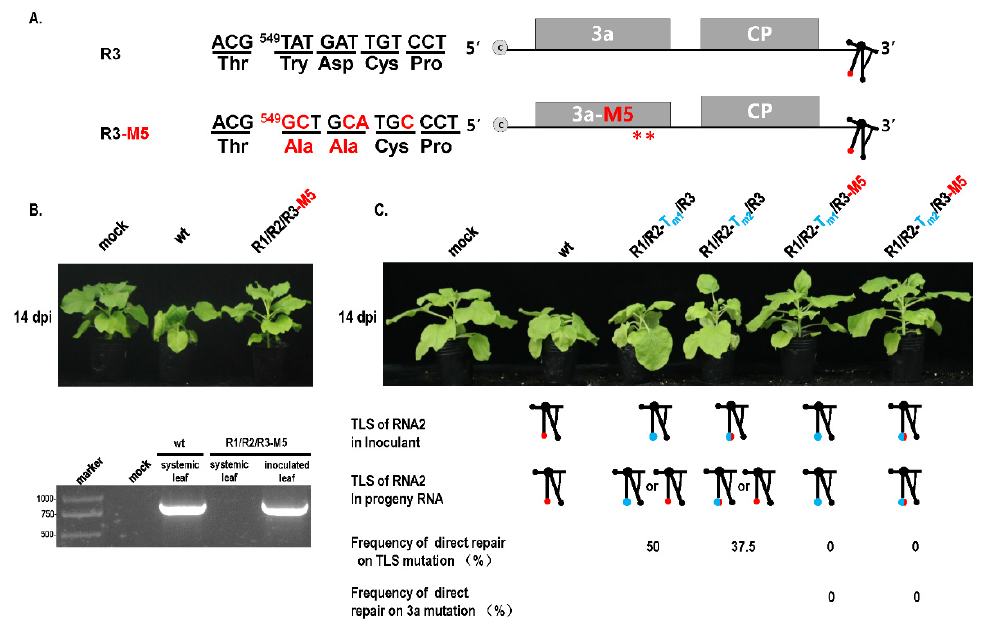
Figure 6. Repair assay of TLS mutation in RNA2 with movement-defected CMV. ( A ) Mutation on movement protein 3a in CMV. Mutation of nucleotide and amino acid is marked in red. **—Mutation at two amino acids in 3a protein. ( B ) Effect of 3a mutation on pathogenicity of CMV. ( C ) Effect of 3a mutation on repair of TLS mutation in RNA2.